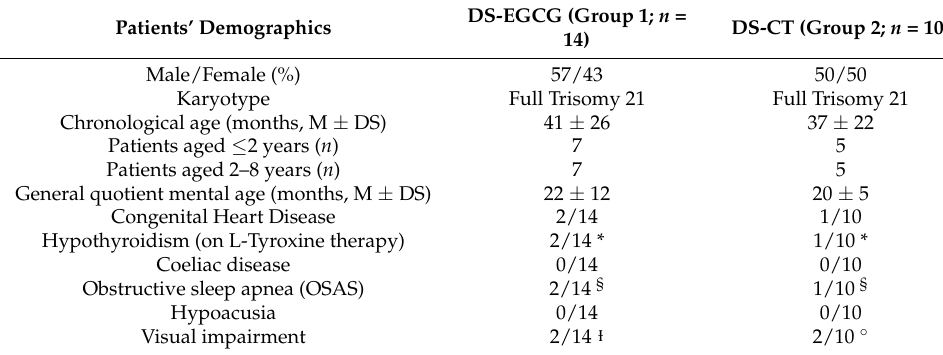
Table 2. Patients’ demographics at enrollment.